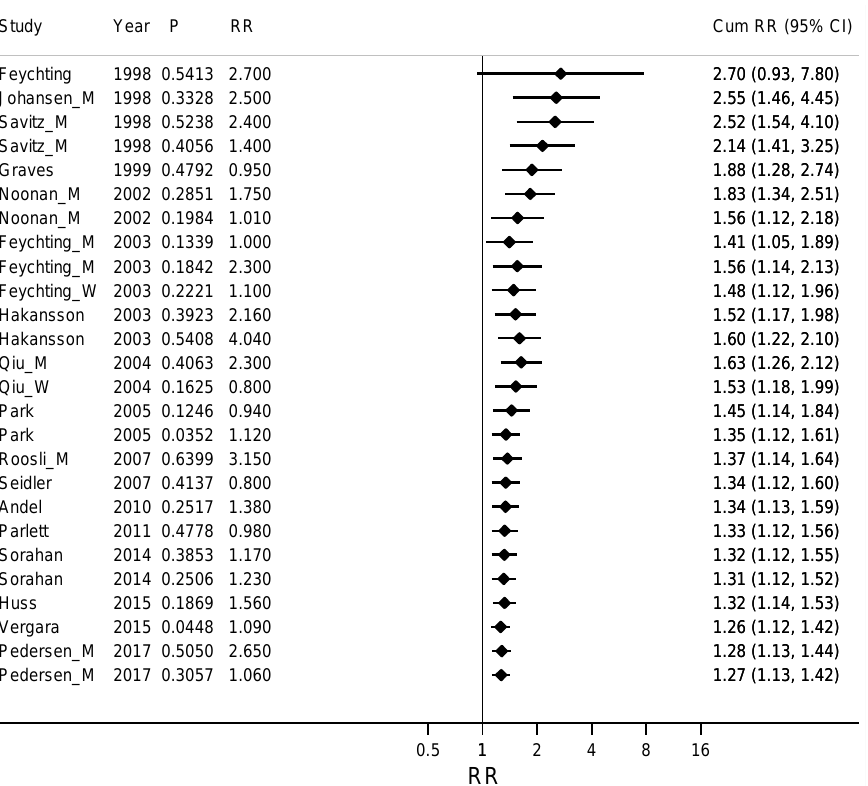
Figure 2. Cumulative meta-analyses by ordered study year from early to late years on the association between ALS (amyotrophic lateral sclerosis) and Alzheimer’s disease together and occupational exposure to electromagnetic fields (EMFs) with the pooled estimate (Cum RR) updated for every new study. Column P gives a measure of the precision for the confidence interval for RR, where large P stands for a wide confidence interval and small P for narrow and more precise confidence interval. RR is the Relative Risk for the study included in the Cum RR. The corresponding funnel plots of studies on ALS and Alzheimer’s disease together (see Figures 3) showed an evident publication bias.